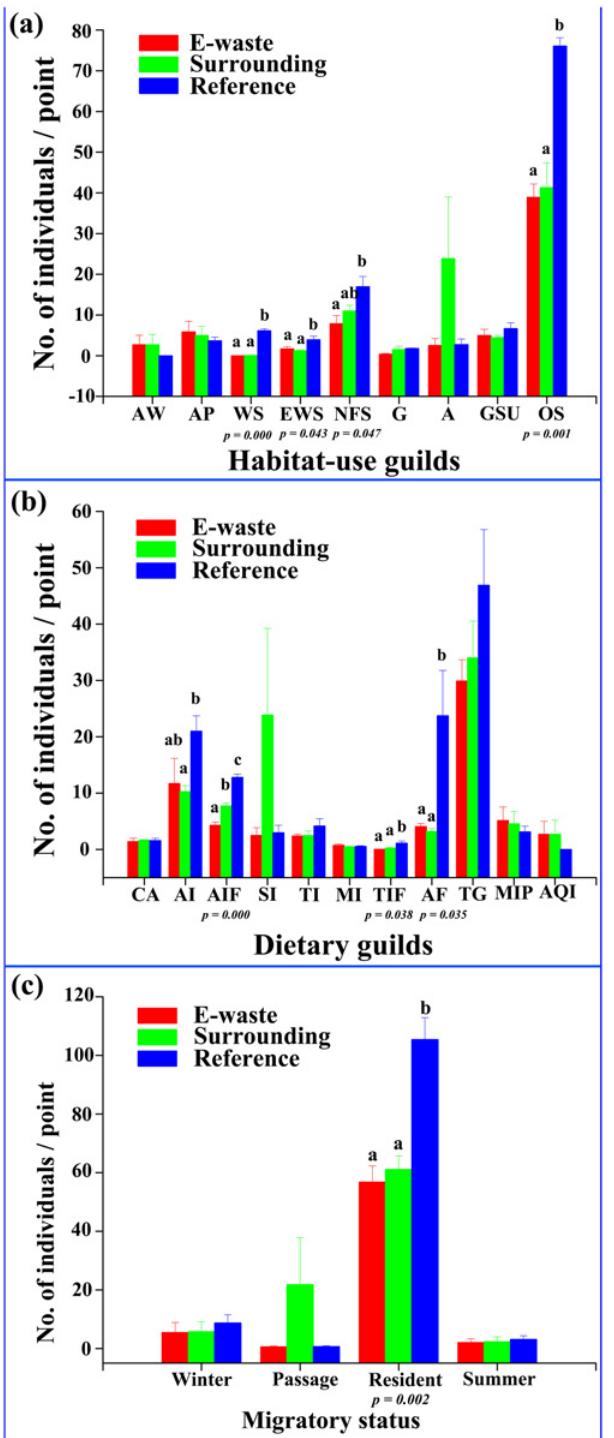
Fig 4. Changes in the relative abundance of birds grouped by (a) habitat preference, (b) dietary guilds, and (c) migratory status. Habitat preference codes: “ artificial marshland or wetland (AW) ” ; “ aquatic ponds and paddy (AP) ” ; “ woodland specialist (WS) ” ; “ edge-tolerant woodland species (EWS) ” ; “ non-forest dependent species (e.g., plantation and orchard; NFS) ” ; “ generalist (G) ” ; “ aerial species (A) ” ; “ grassland and shrub users (GSU) ” and “ open-habitat species (OS) ” . Dietary guild codes: “ carnivore (CA) ” , “ arboreal